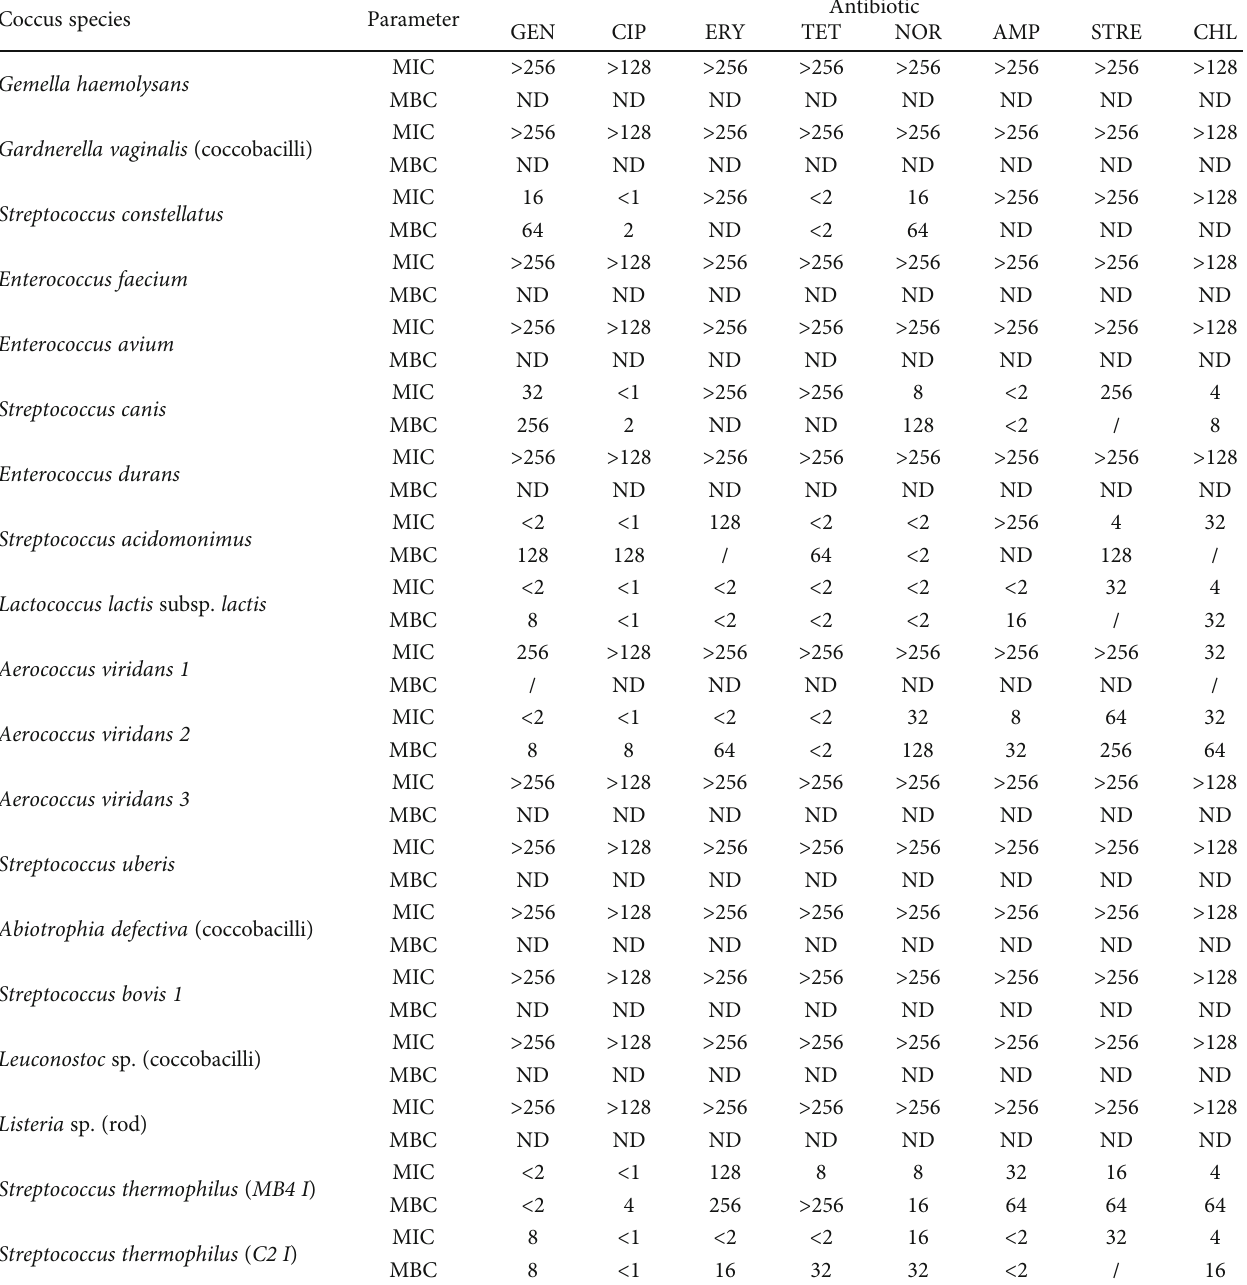
Table 6: The susceptibility of cocci, coccobacilli, and rod species to some conventional antibiotics. Coccus